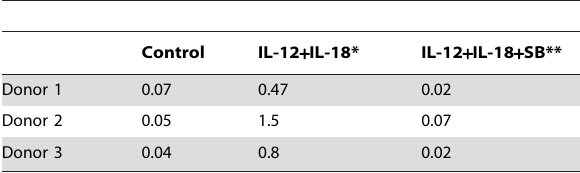
Table 1. Percentage of IFN- c + CD4 + T cells as determined by intracellular